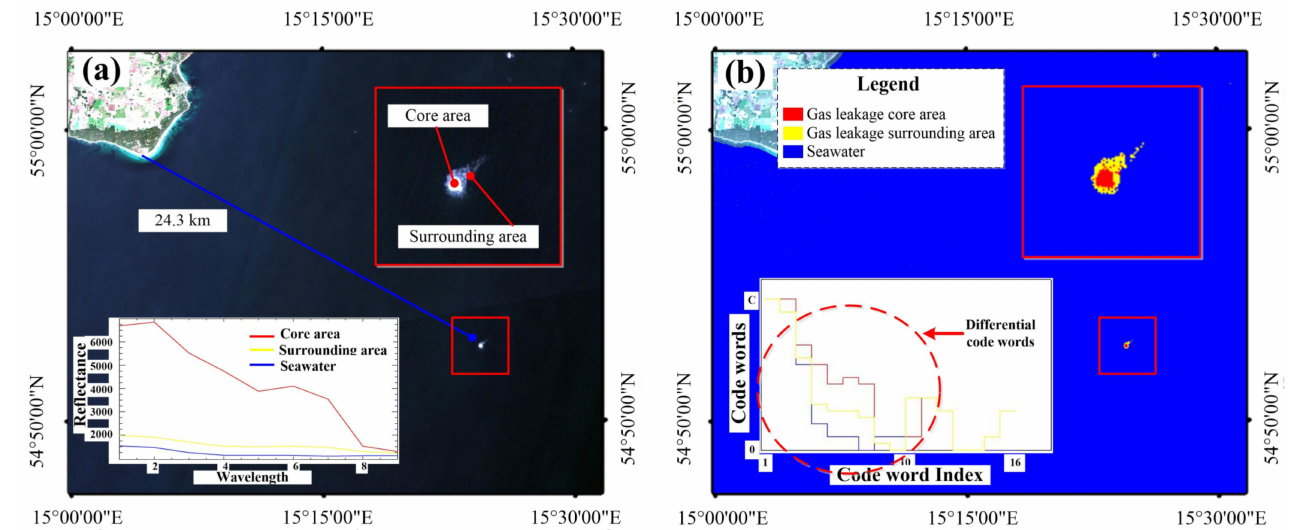
Figure 11. The experimental data 7 (( a ), captured by the Sentinel-2 satellite) and its natural gas leakage detection result produced by the MSE method with SSI ( b ). Differential code words could be observed in the red